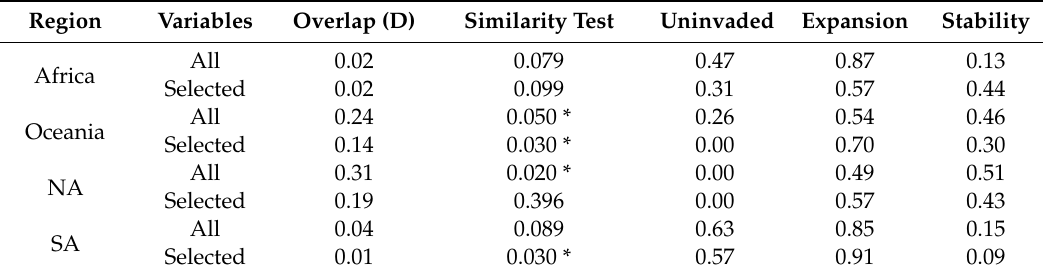
Table A1. Summary of p values for the niche test of Sirex Woodwasp between invasive ranges Africa, Oceania, North America (NA) and South America (SA) and native range Eurasia (EUA) using all and